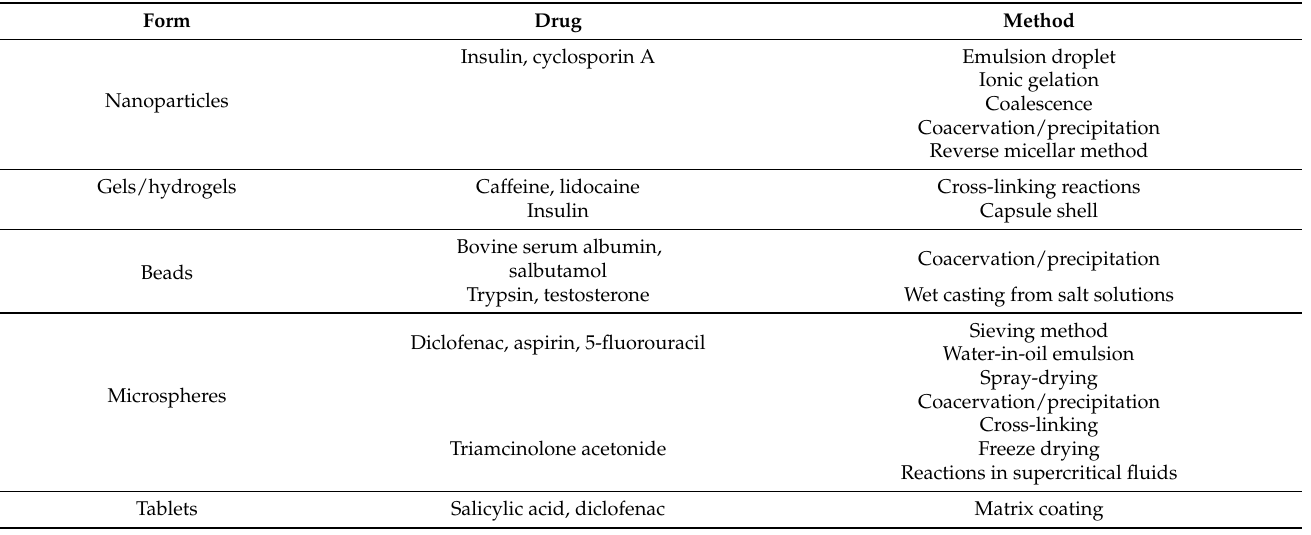
Table 2. Chitosan-based drug delivery systems prepared by different methods reviewed in reference [18].